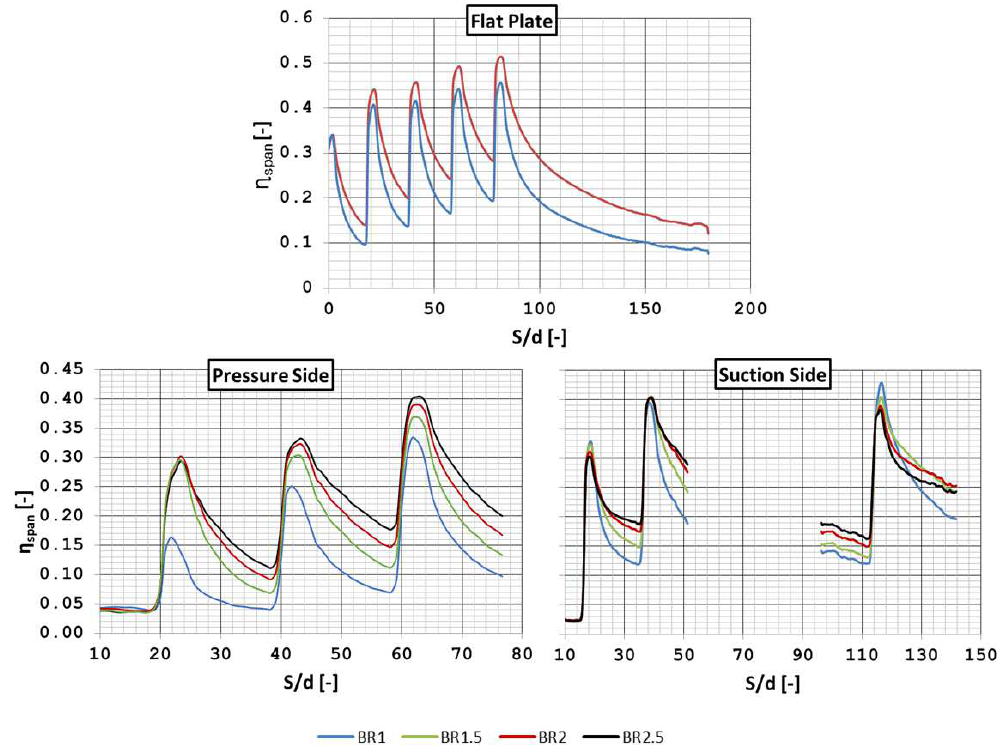
Figure 6. Spanwise average effectiveness 1D profile: effect of blowing